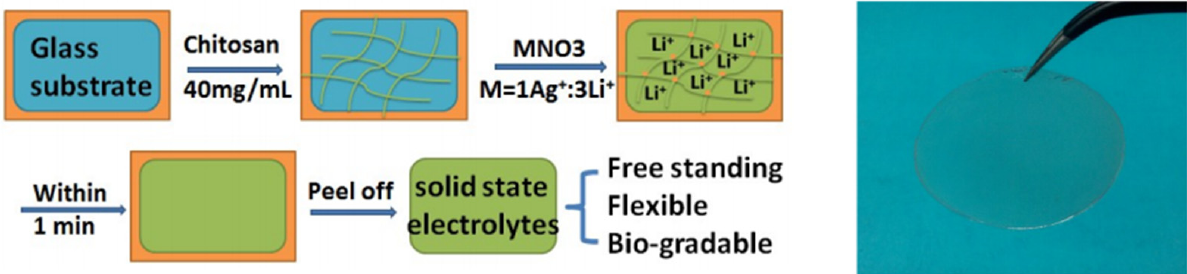
Figure 6. Synthesis of a flat-structured free-standing solid polymer superamolecular hydrogel electrolyte. Reprinted under an open access CC-BY licence [135].